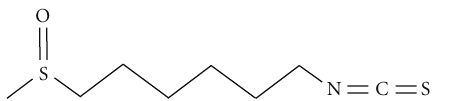
Figure 1: Chemical structure of 6-MSITC. 6-MSITC contains methyl sulfoxide group and ITC group linked by alkyl